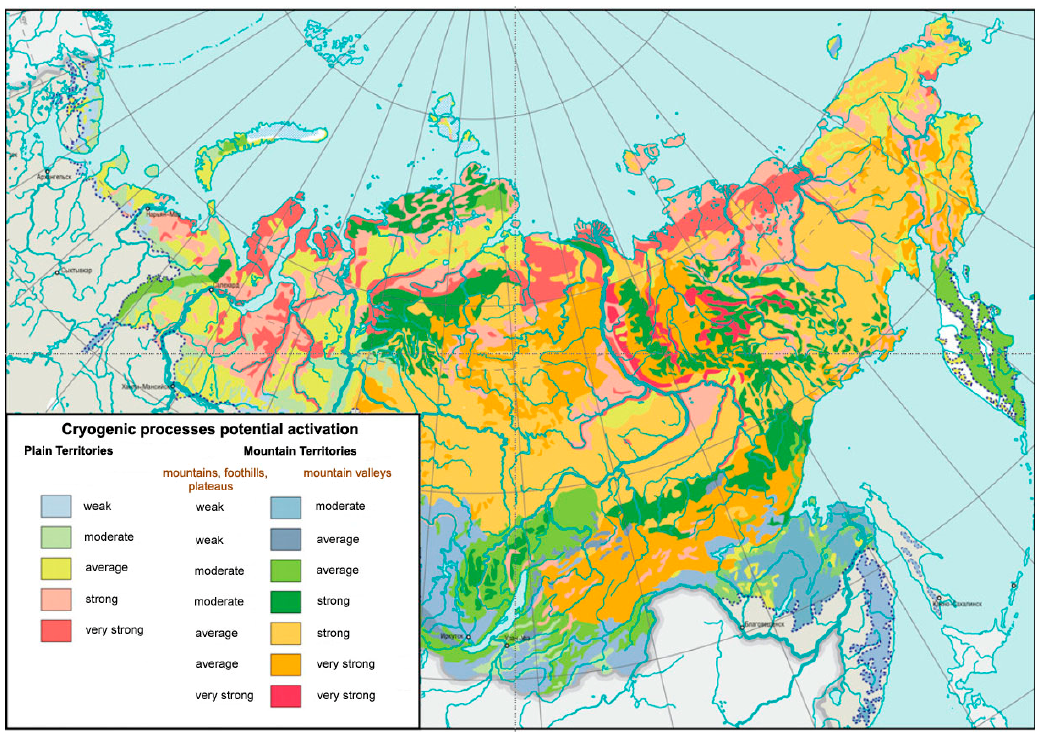
Figure 12. The map of the potential for cryogenic process occurrence.